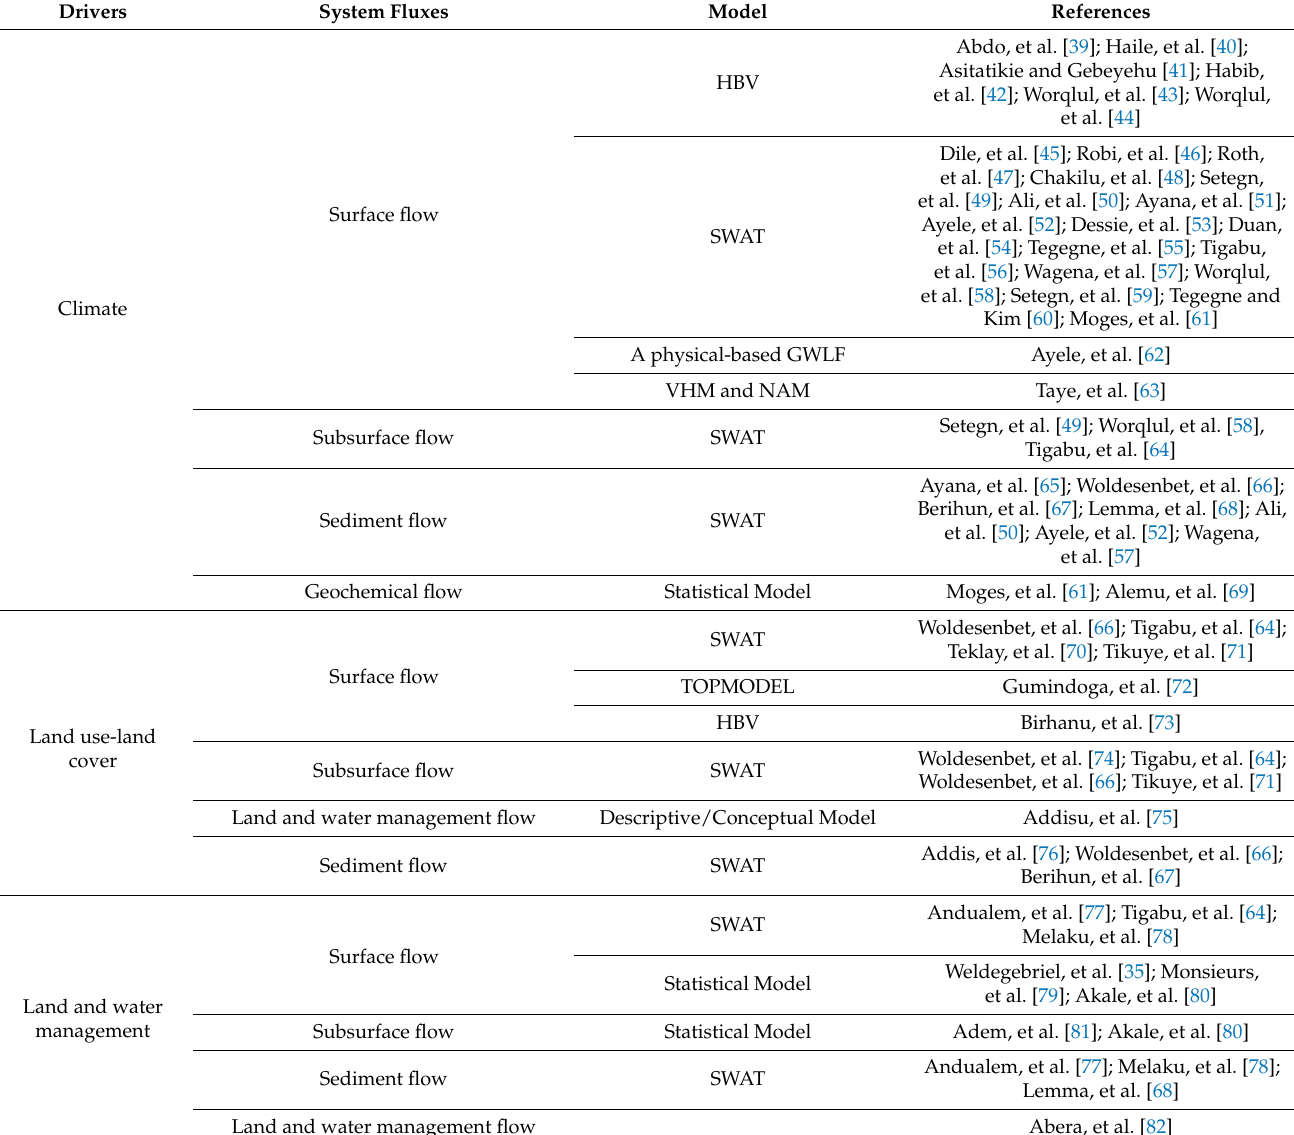
Table 3. Assessment connectivity using the implicit approach in the Lake Tana